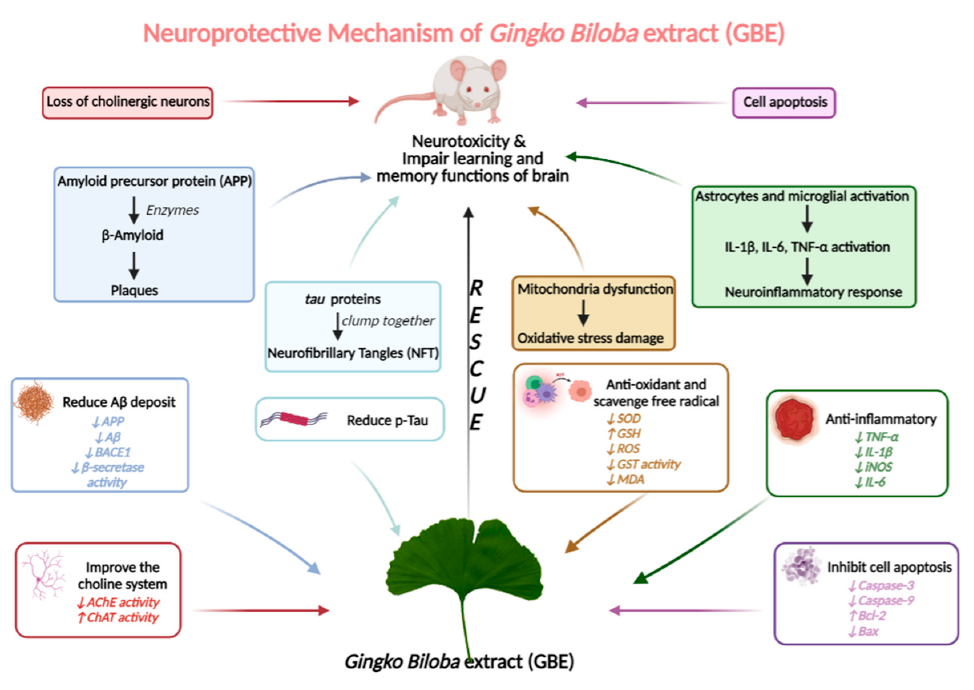
Figure 9. Possible neuroprotective mechanism of GBE.